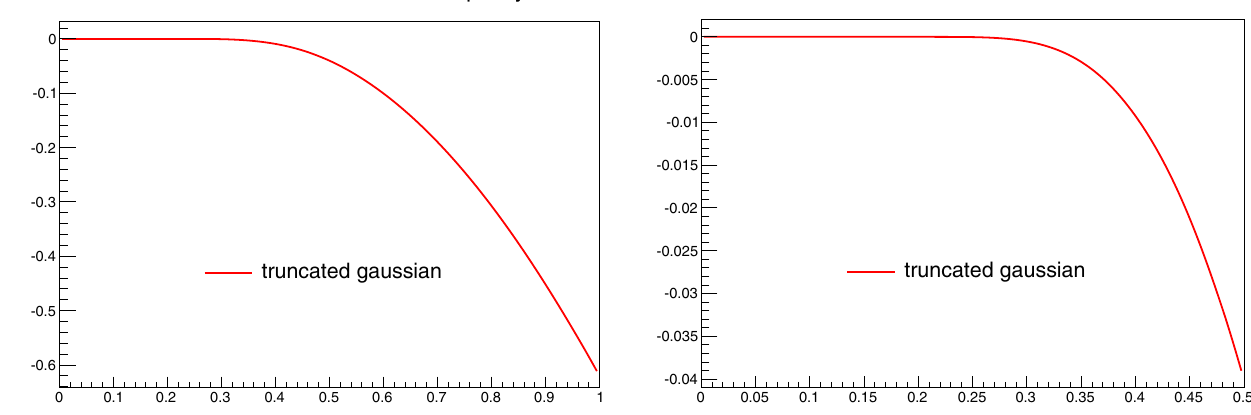
Fig. 4. Relative error on standard deviation value. Table 1. Relative error between moments of the approx- imative law and expected moments.